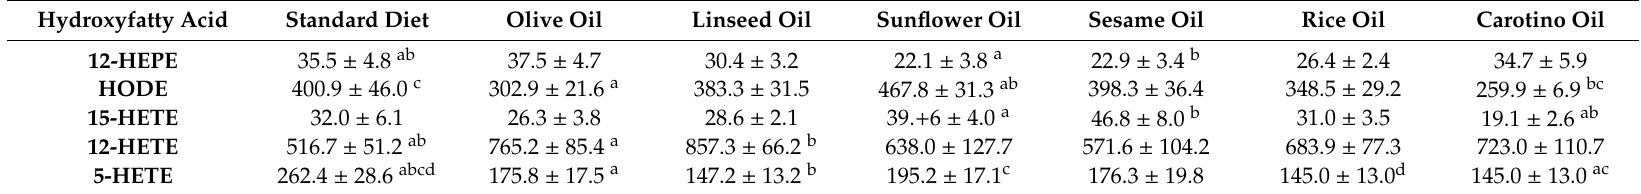
Data were expressed as mean values ± standard error of mean. Values in a row with the same superscript (a, b, c or d) are significantly different in Kruskal–Wallis test followed by multiple comparison test ( p < 0.05).